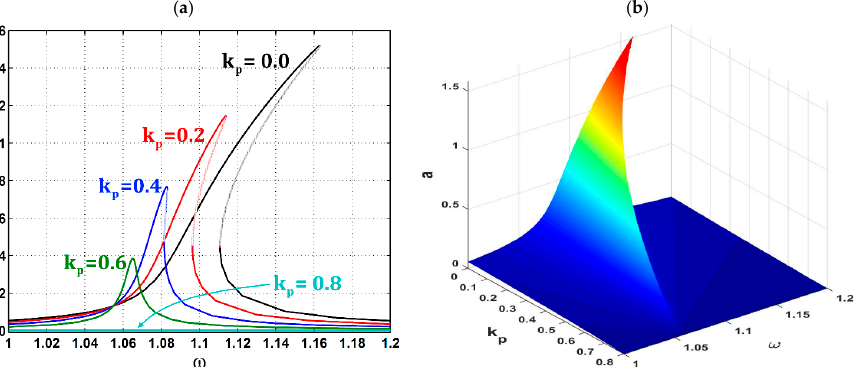
Figure 9. Relationship between the car’s oscillation amplitude a and ( a ) the excitation frequency ω at different values of CP control gain k p , ( b ) both the excitation frequency ω and CP control gain k p post-control ( k v =